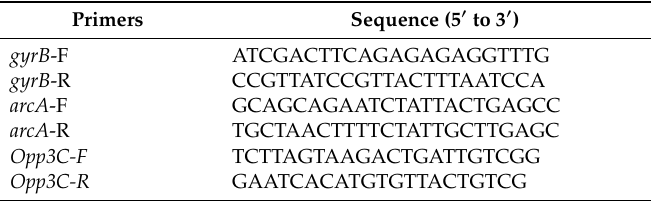
Table 2. Primers for comparison of gene expression between the wild type and the mutants using